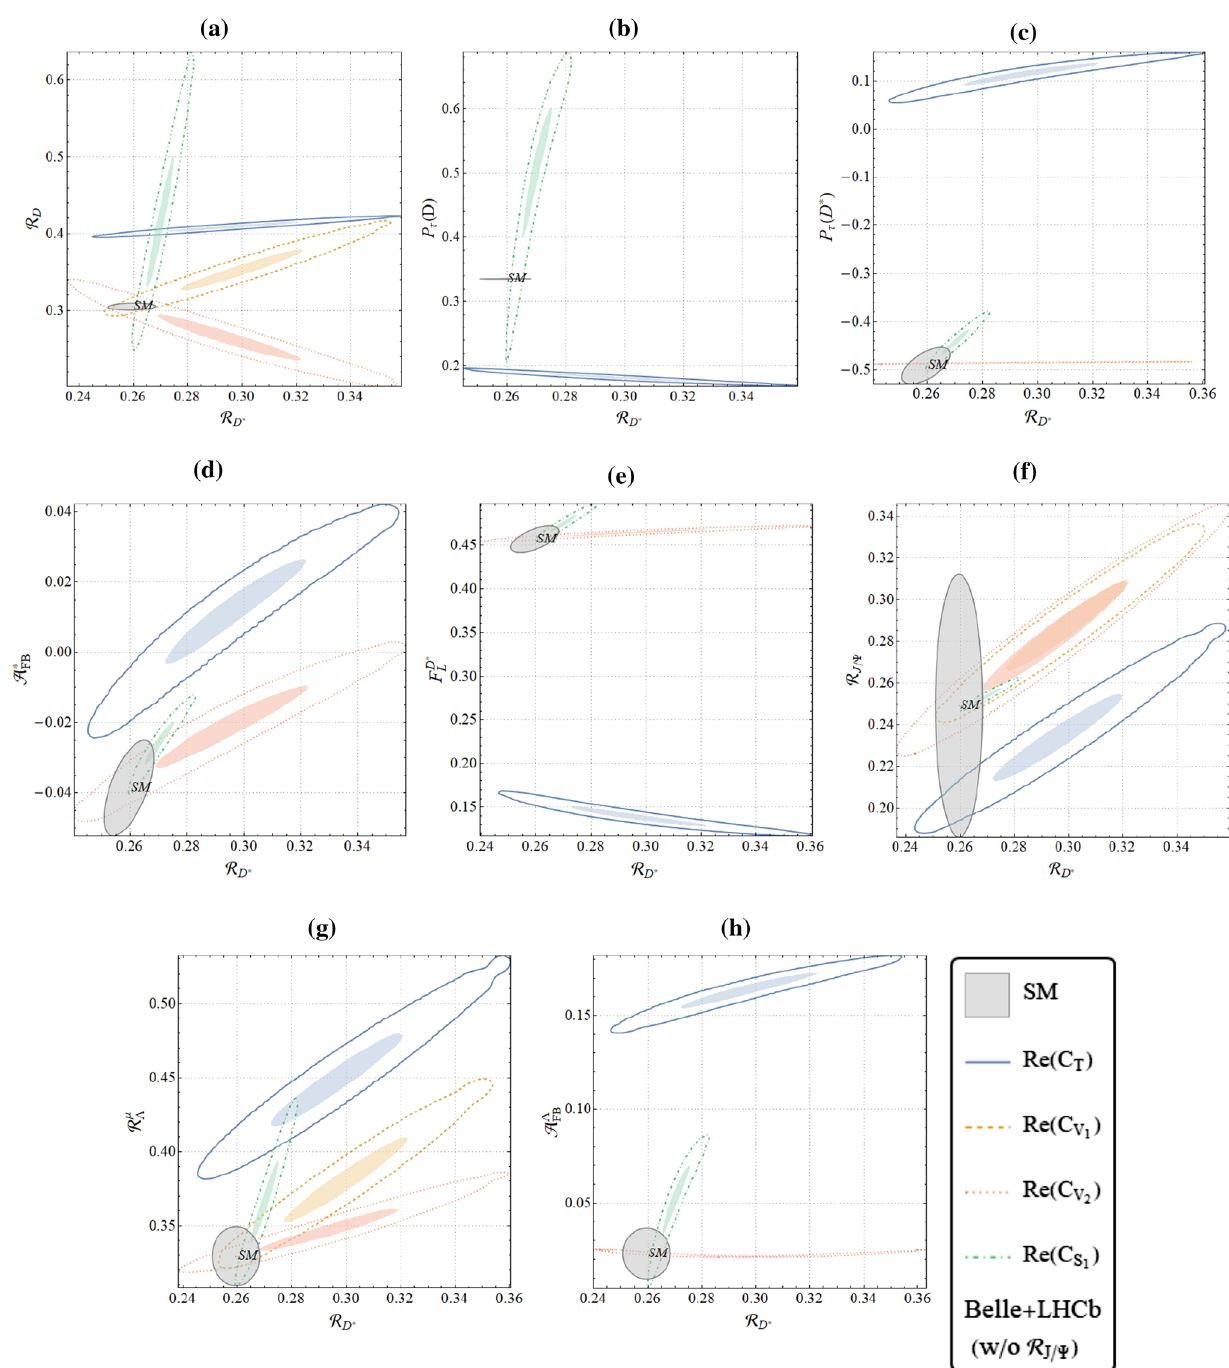
) , R e ( C ) , and R e ( C ) V 2 S 1 1